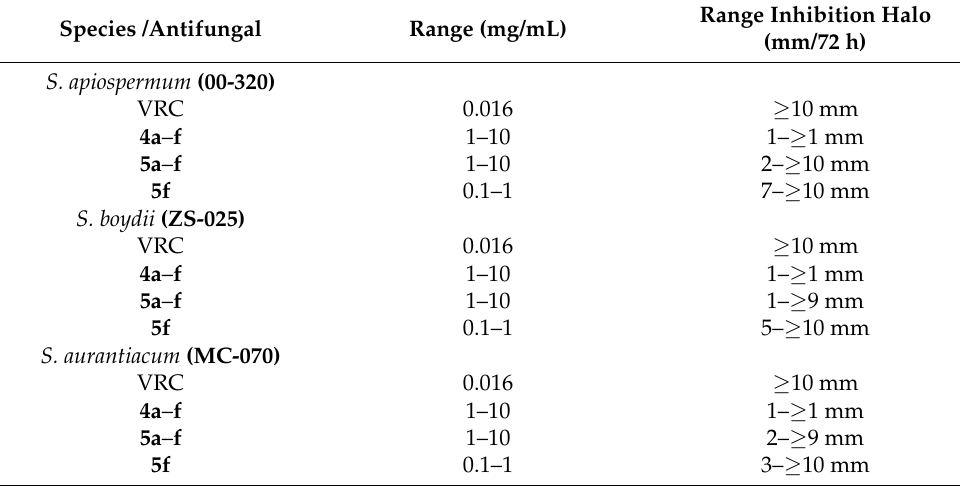
Table 3. In vitro susceptibilities of 3 strains of Scedosporium against voriconazole antifungal and compounds 4a – f and 5a – f in the agar diffusion